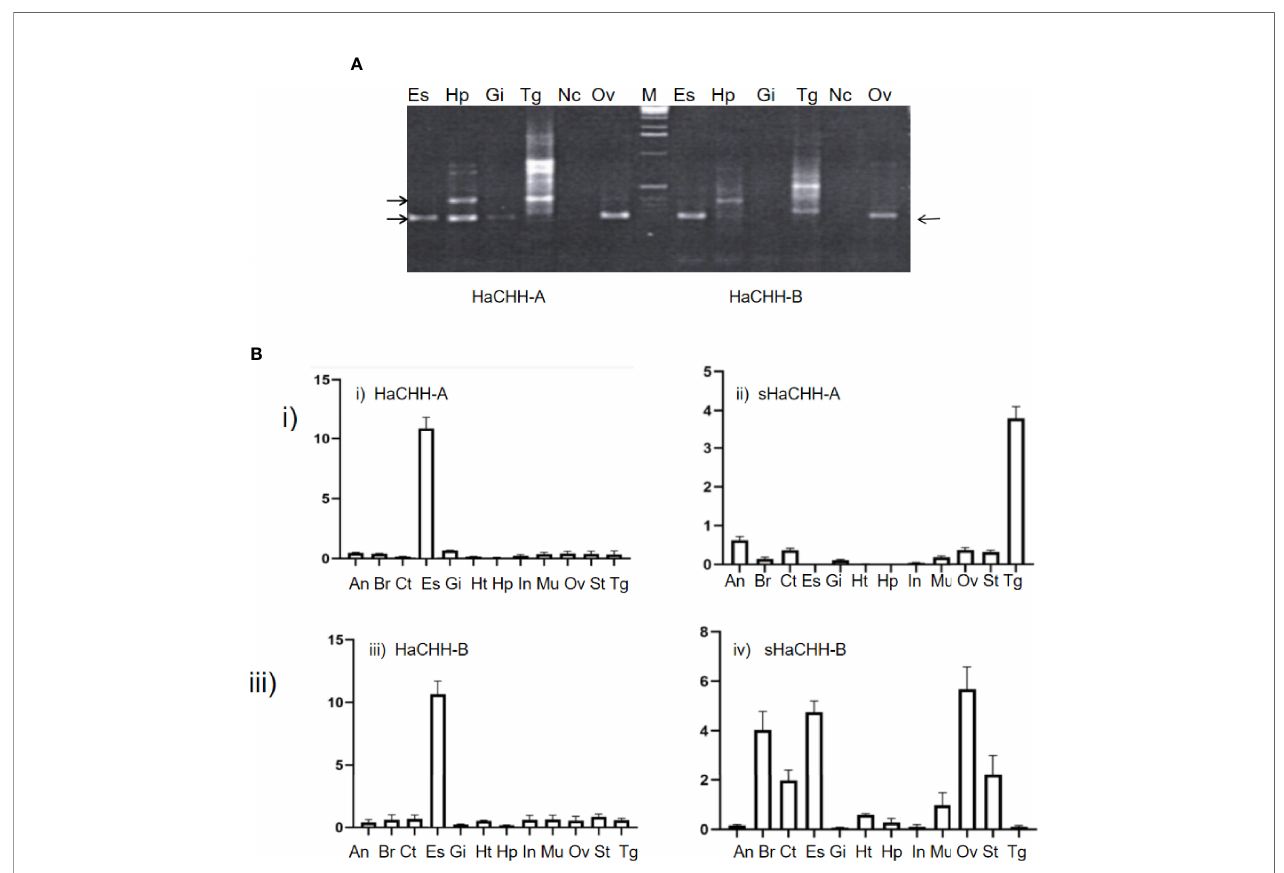
FIGURE 6 | (A) RT-PCR expression study of the HaCHH-A , sHaCHH-A , HaCHH-B , and sHaCHH-B genes in different tissues of the lobster female. The primers F1A and RP were used to amplify HaCHH-A and sHaCHH-A , while primers F1B and RP were used to detect the transcripts of HaCHH-B and sHaCHH-B in the different tissues [eyestalk ( Es ), hepatopancreas ( Hp ), gill, ( Gi ), thoracic ganglion ( Tg ), nerve cord ( Nc ), and ovary ( Ov )] of lobster during the early reproductive stage (stage I). (A) Representative agarose gels showing the detection of HaCHH-A . HaCHH-B , sHaCHH-A , and sHaCHH-B . The larger (317 bp) fragment is the sHaCHH- A or sHaCHH-B and the smaller (158 bp) fragment is the ampli fi ed partial HaCHH-A and HaCHH-B cDNA. (B) qPCR expression study of the i) HaCHH-A , ii) sHaCHH-A , iii) HaCHH-B , and iv) sHaCHH-B genes in different tissues of the female lobster. Primers HaCHH-AF/HaCHH-AR and sHaCHHAF/sHaCHHAR were used to amplify HaCHH-A and sHaCHH-A . Primers HaCHHAF/HaCHHAR and sHaCHH-BF/sHaCHH-BR were used to detect the transcripts of HaCHH-B and sHaCHH- B in the different tissues [abdominal nerve ( An ), brain ( Br ), cuticle ( Ct ), eyestalk ( Es ), hepatopancreas ( Hp ), heart ( Ht ), gill ( Gi ), intestine ( In ), muscle ( Mu ), stomach ( St ), thoracic ganglion ( Tg ), nerve cord ( Nc ), and ovary ( Ov )] of lobster during the middle stage of reproduction